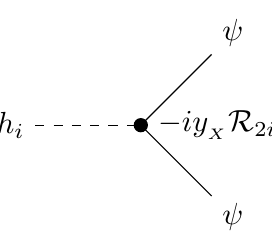
Figure 3 . The vertex relevant for the FDM